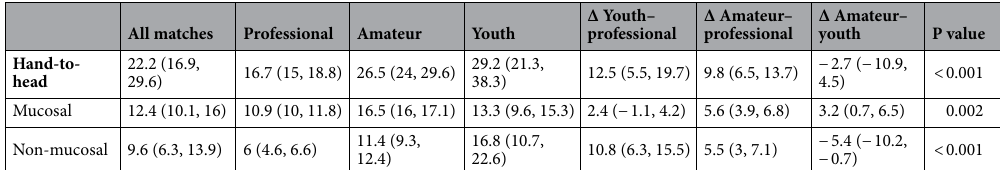
Table 4. Within-player hand-to-head contacts during match play. Data are presented as frequency per player- hour and as median with interquartile range. Differences between playing levels are displayed as median differences with 95% confidence intervals. P values from Kruskal–Wallis